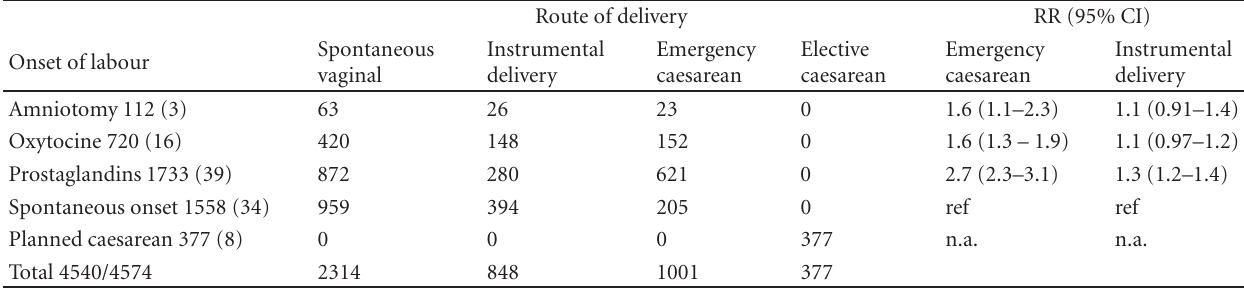
Table 3: Process of labour in pregnancies complicated by SGA and hypertensive disorders (with or without proteinuria).